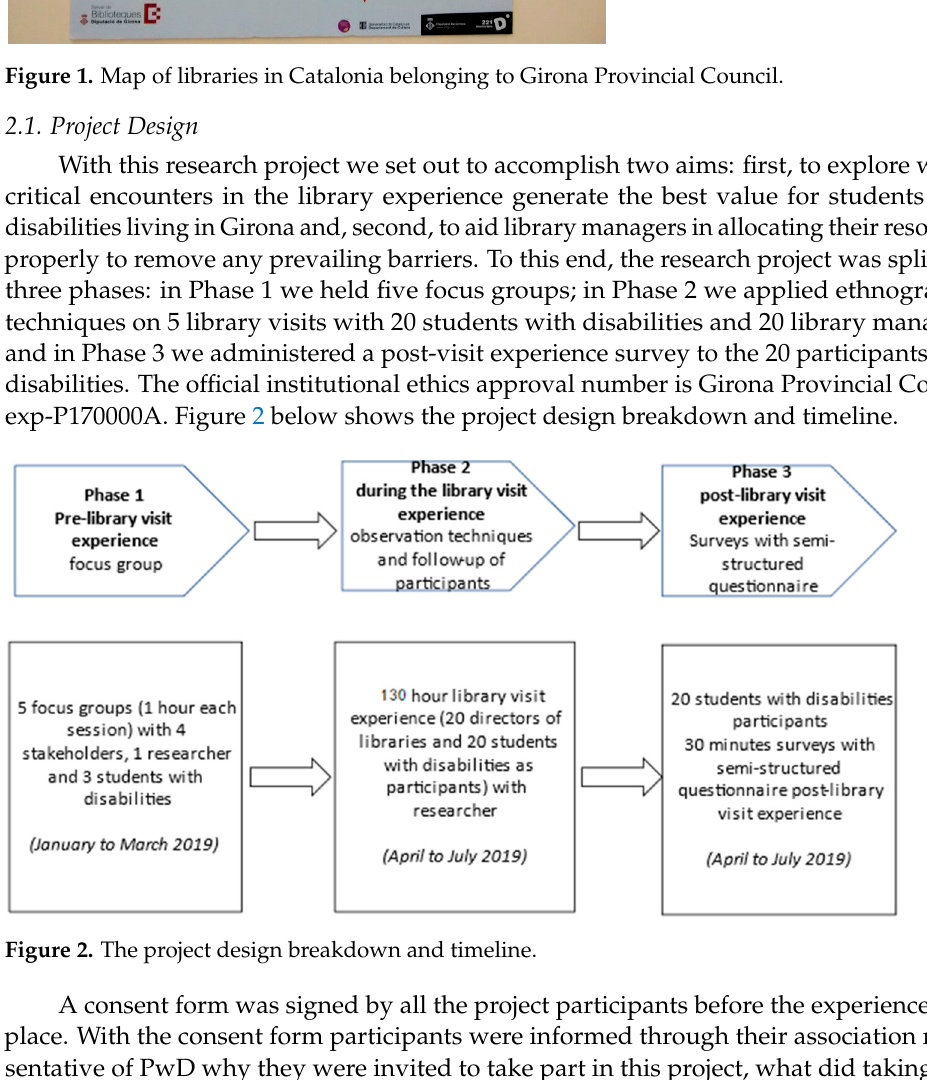
Figure 2. The project design breakdown and timeline.